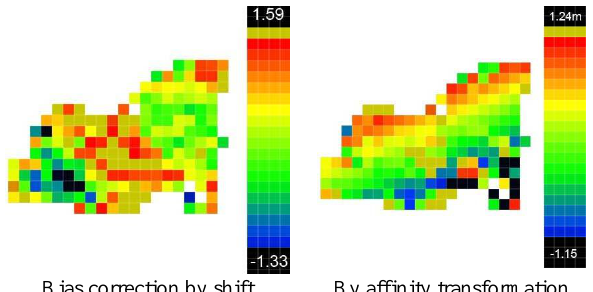
Figure 14. Systematic height errors of Pleiades DSM